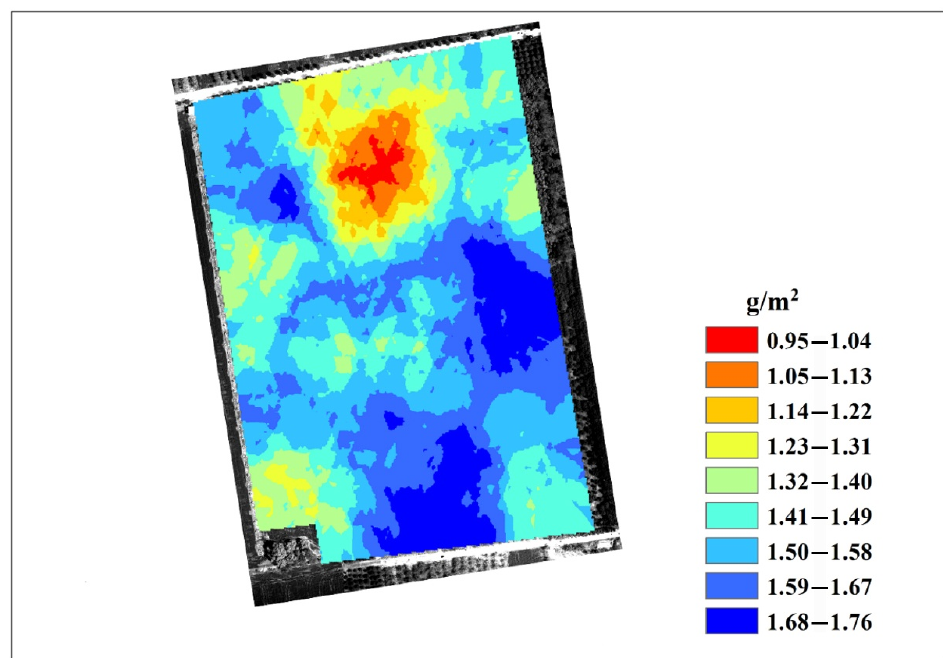
Figure 7. Mapping of AGB in the whole field.